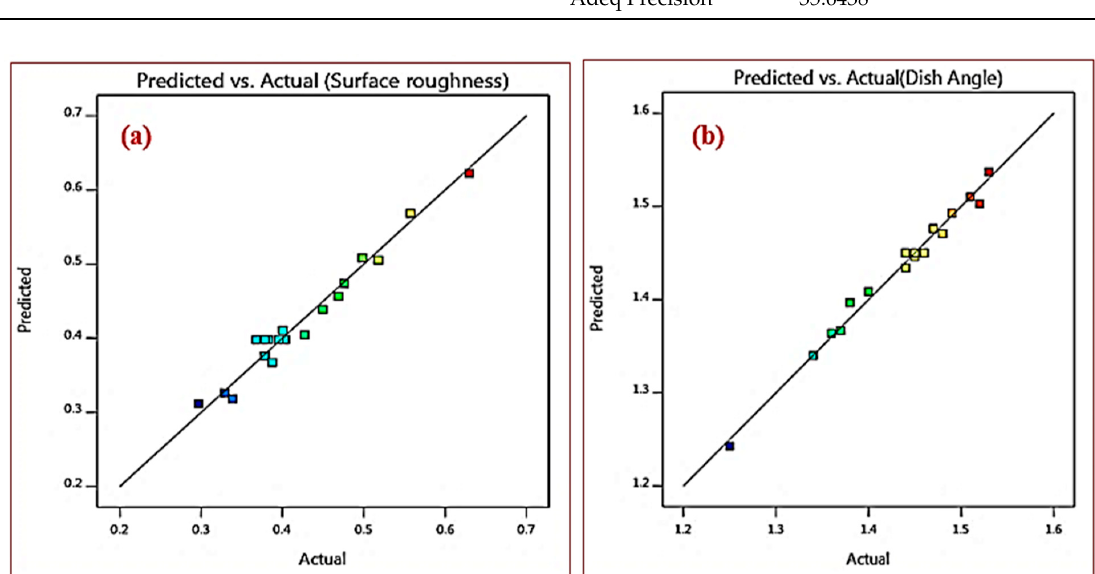
Figure 7. Prediction versus Actual correlation graphs ( a ) surface roughness ( b ) dish angle.